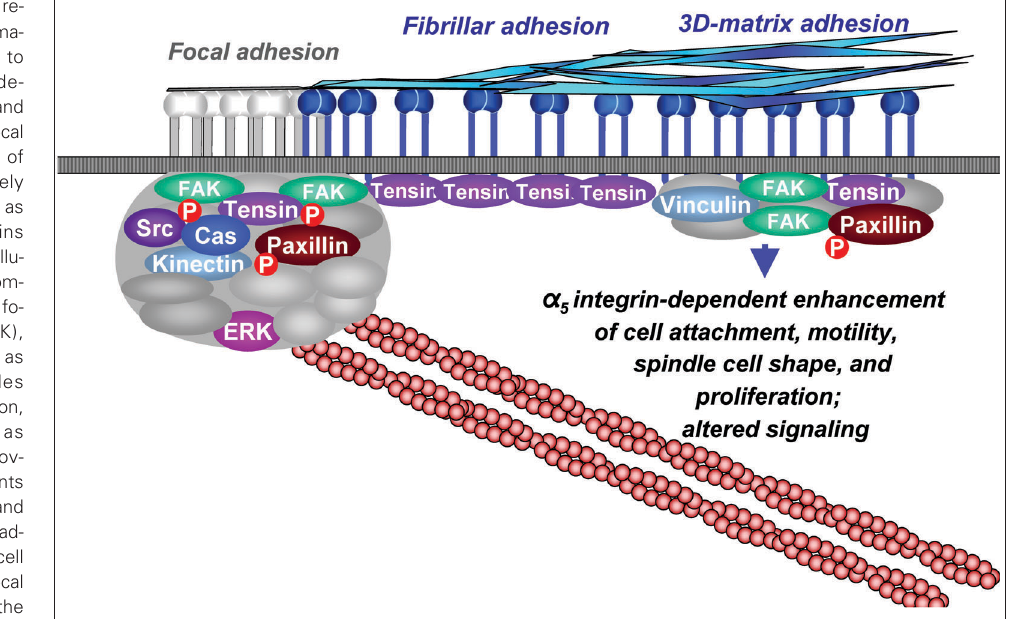
Figure 4. Summary of cellular re- sponses to the extracellular ma- trix. The responses of cells to extracellular matrix differ de- pending on its organization and the type of cell adhesion. Focal adhesions are localized sites